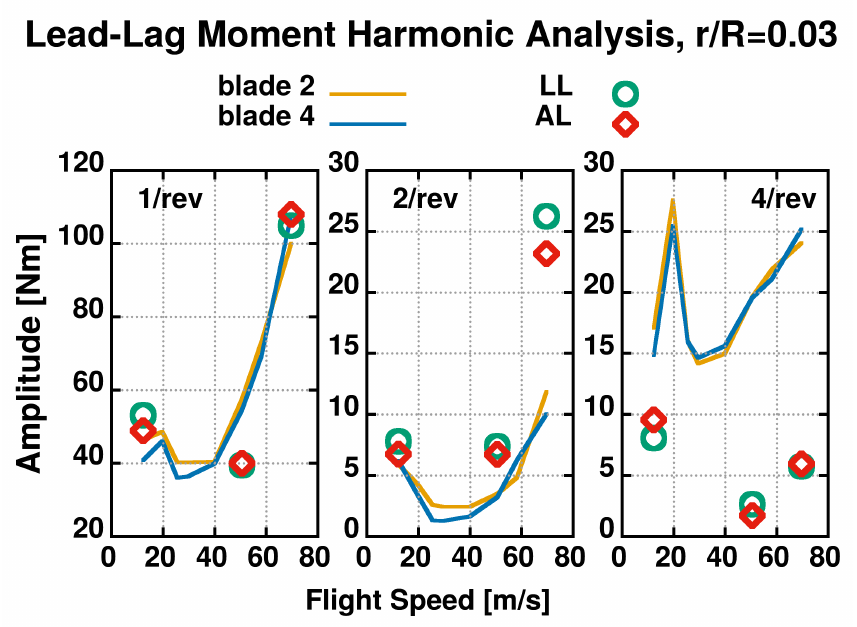
Figure 42. Harmonic analysis of Lead-Lag bending moment. Amplitude of frequencies with the highest energy content.